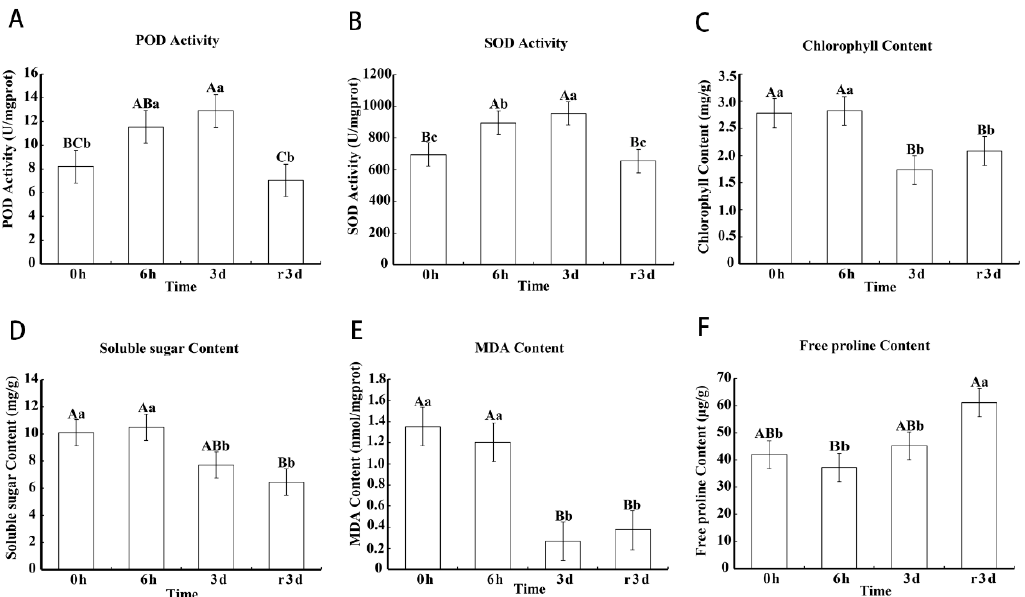
Figure 2. Physiological changes of radish seedlings under heat stress. ( A–F ) The changes in the activities of peroxidases (POD) and superoxide dismutase (SOD), the contents of chlorophyll, soluble sugar, MDA and free proline of the samples in response to heat stress (HS), respectively. Bars with different letters above the columns of figures indicate significant differences at p less than 0.05 (lowercase letters) or less than 0.01 (capital letters).